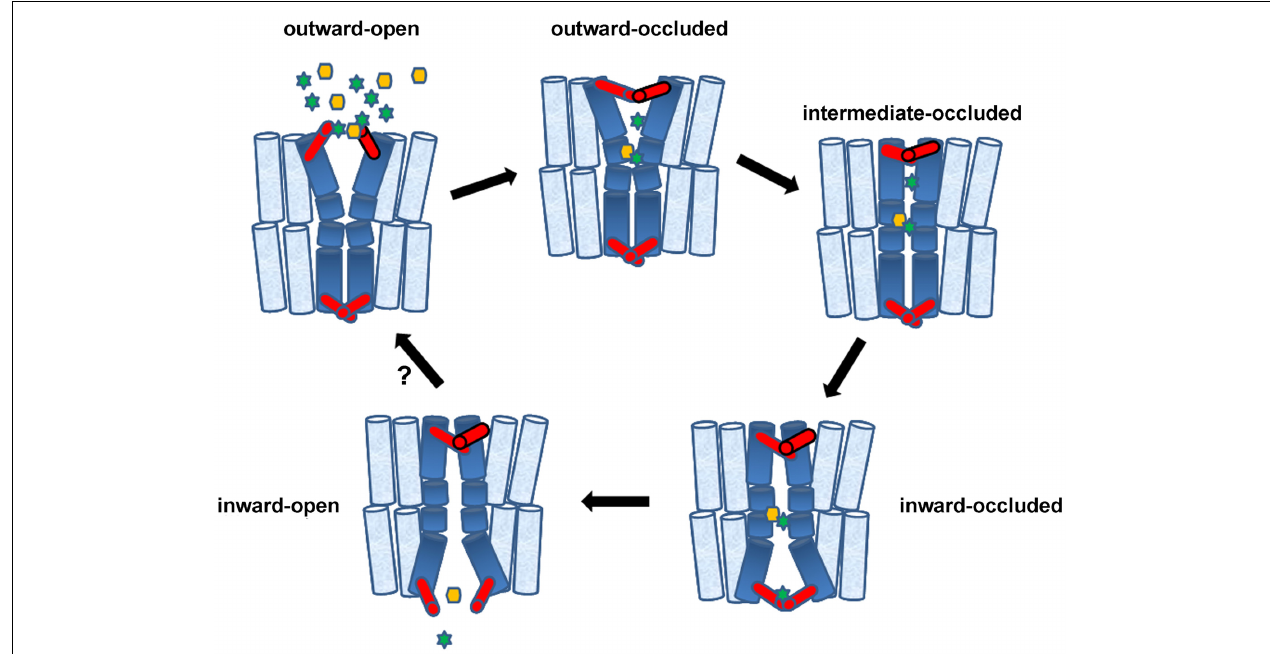
FIGURE 2 | Transporters in action and the role of gates. Accumulating evidence supports a theoretical trailer of alternating transporter conformations involving five structurally distinct basic conformations: (1) outward-facing with extracellular gate open (cytoplasmic gate occluded), (2) outward-facing with extracellular gate occluded (cytoplasmic gate remains occluded), (3) intermediate with both gates occluded, (4) inward-facing with gates occluded, (5) inward-facing with only cytoplasmic gate open. Gates, shown in red, can be made by a few flexible amino acids or bigger domains made of parts of α -helices. Starting from (1), binding of Na + or H + (green stars) at the extracellular gate or deeper into the major substrate-binding pocket, stabilizes the outward-facing open state, creating a high-affinity substrate-binding site deep in the transporter body. Substrates (yellow hexagon) might also bind selectively to the extracellular gate. Following substrate and potentially additional ion